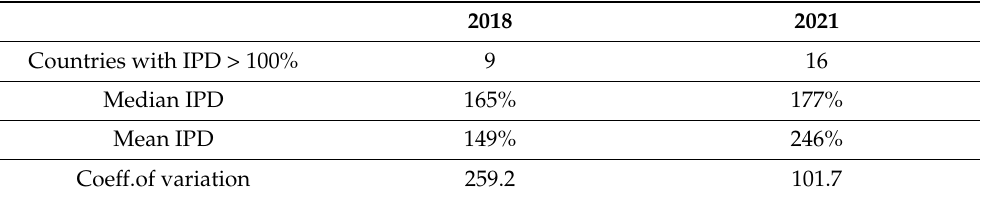
Table 5. The impact of the discount rate—number of countries with IPD > 100% and comparison between 2018 and 2021 projection